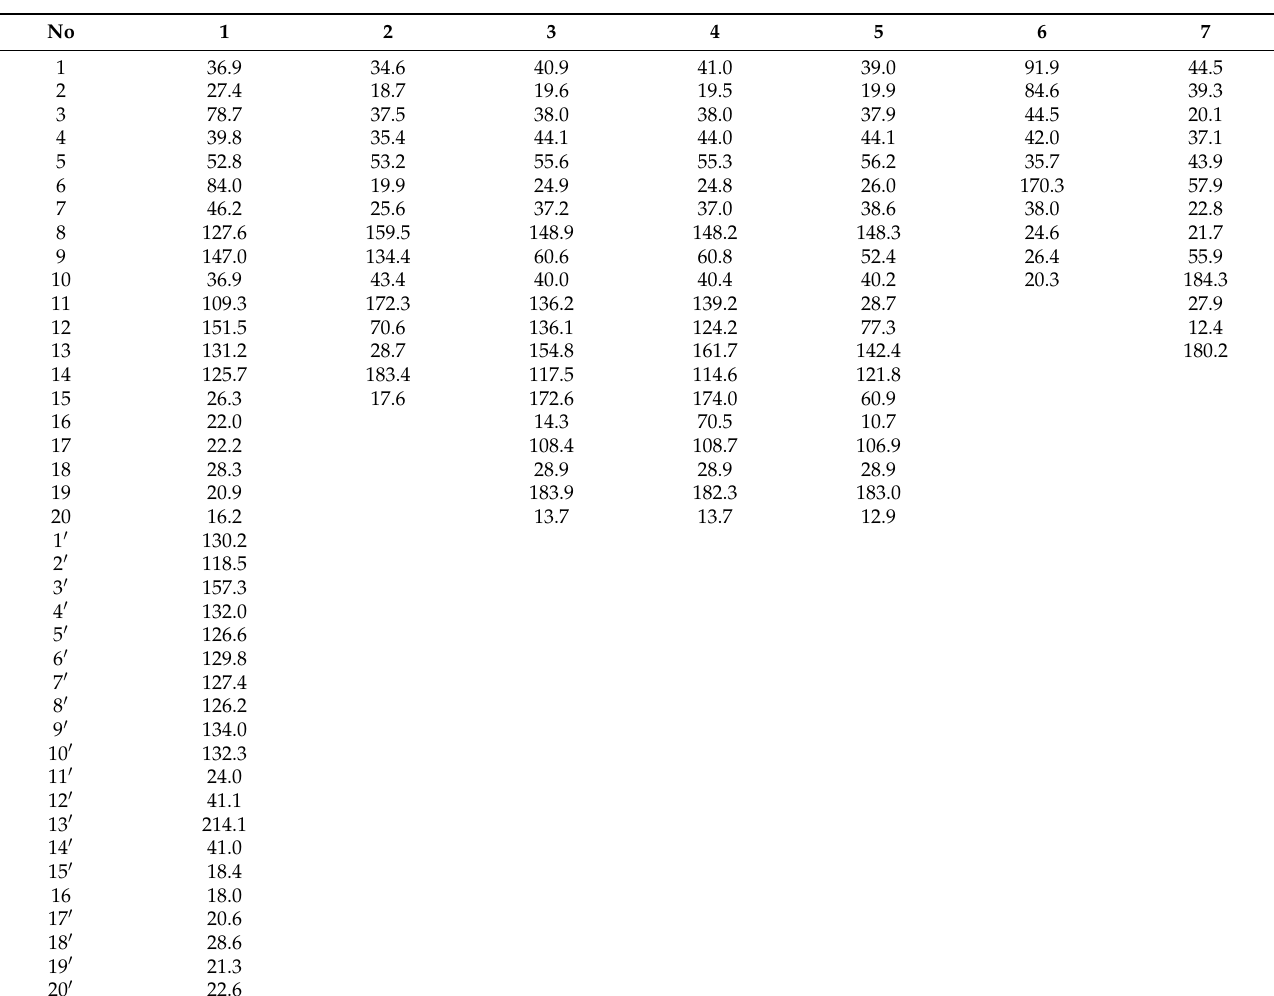
(Figure 2), COSY (Figure 2), and NOESY (Figure 3) were compatible with the structure of 2 as in Figure 1, named chamaecyformosanin B. Table 1. 13 C-NMR Data for Compounds 1 – 7 ( δ in ppm, 125 MHz for 13 C NMR in CDCl 3